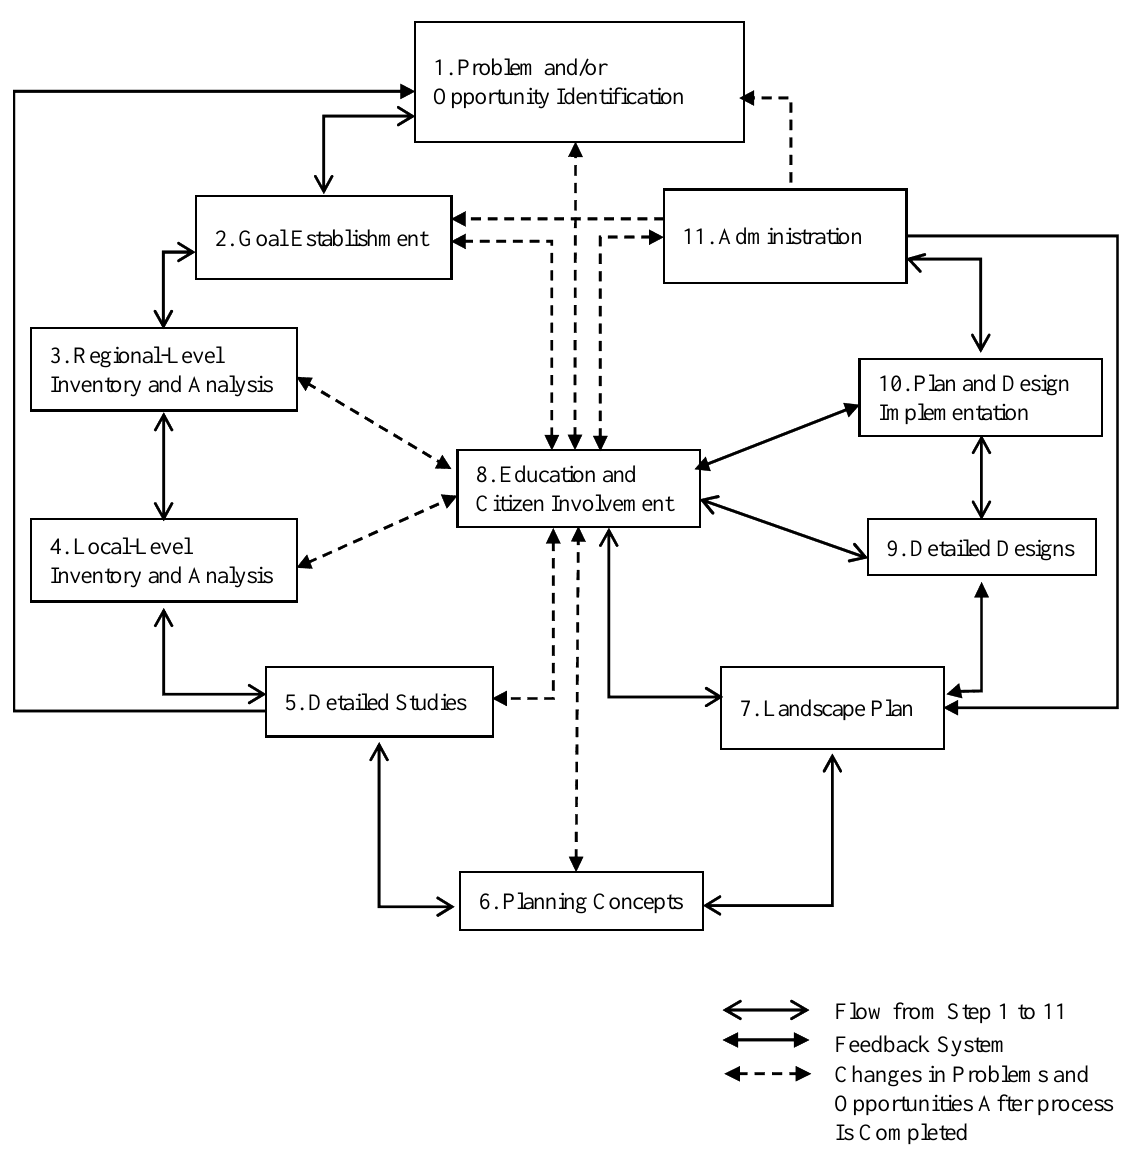
Fig. 2: Ecological Planning Model (Steiner,